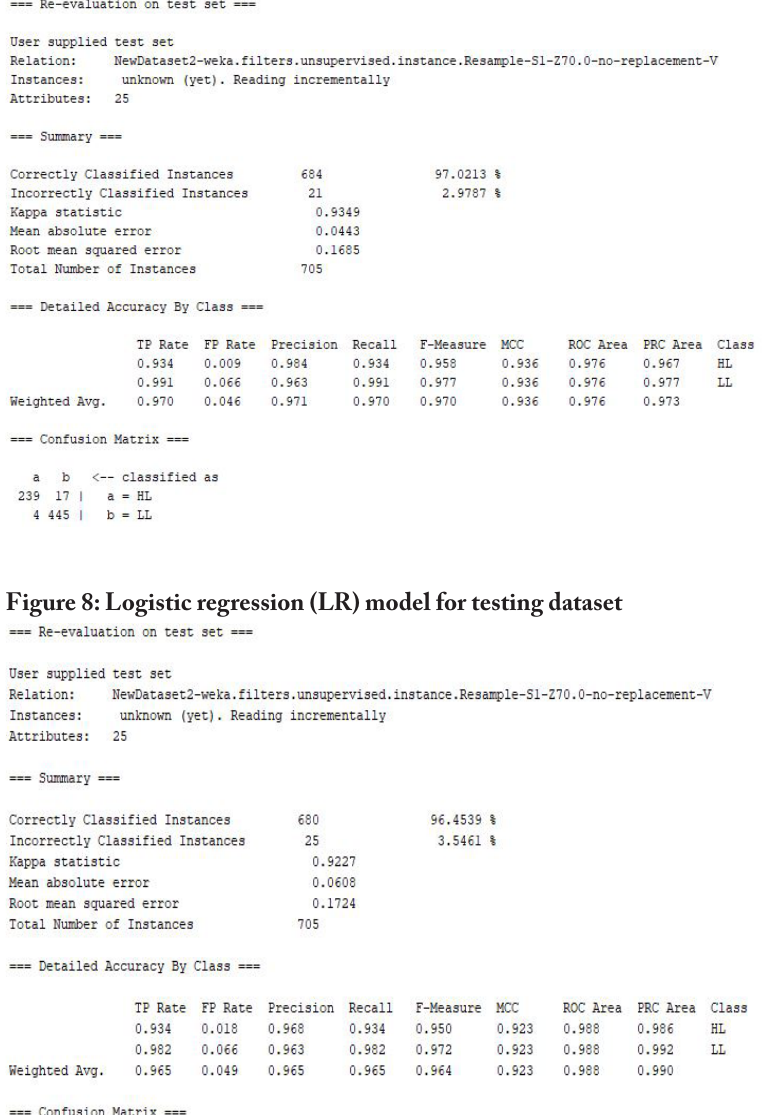
Figure 7: J48 decision tree model for testing dataset